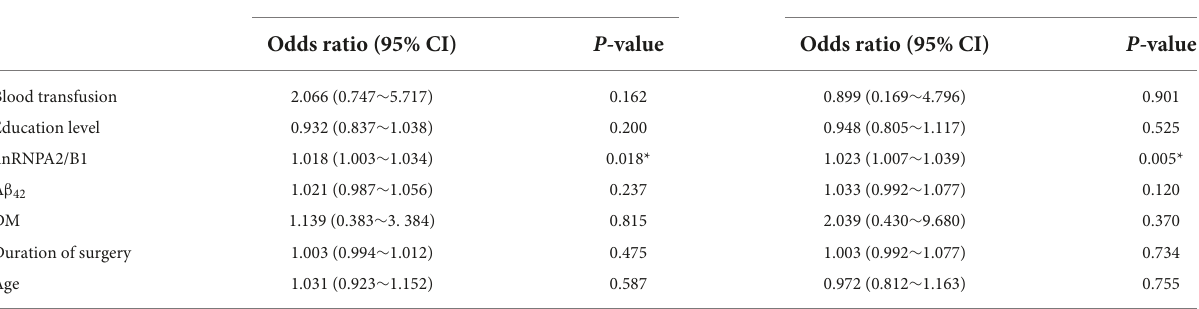
TABLE 5 Multivariate logistic regression